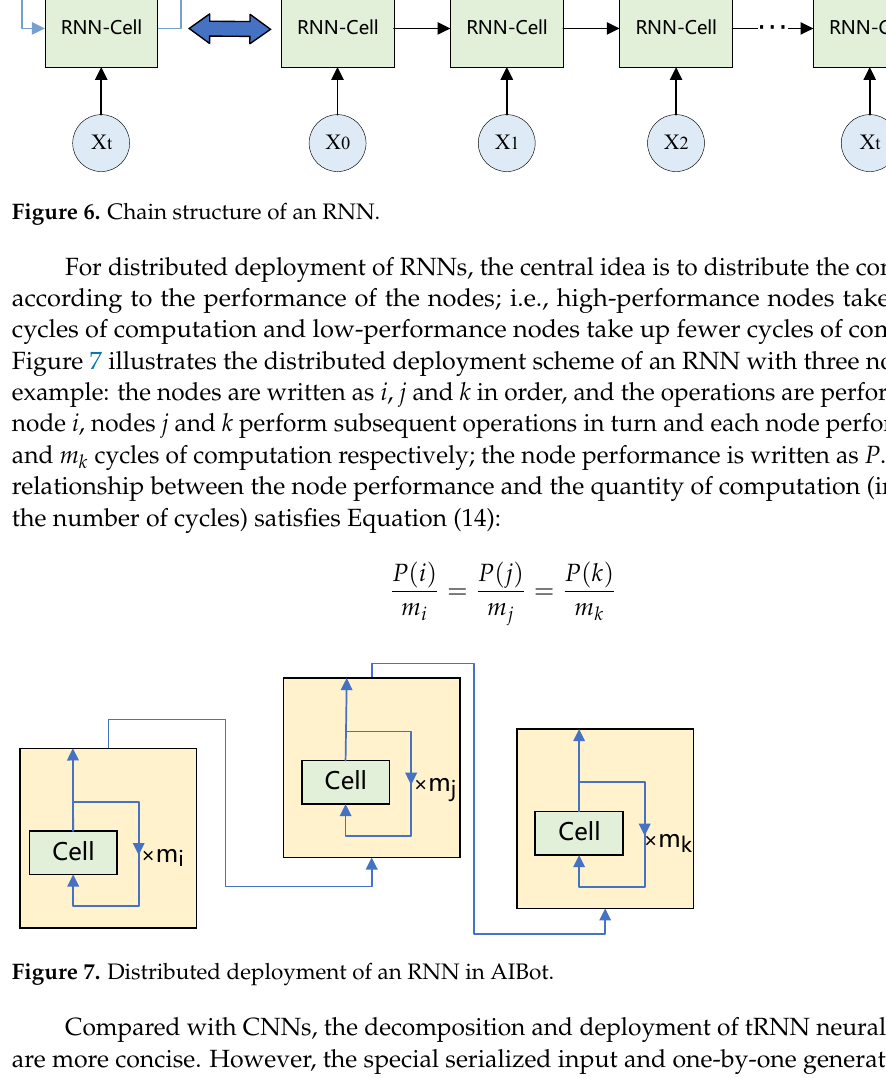
Figure 8. Task execution process.